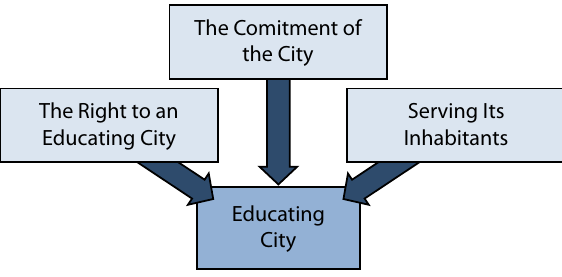
fig. 4. Principles of the educating